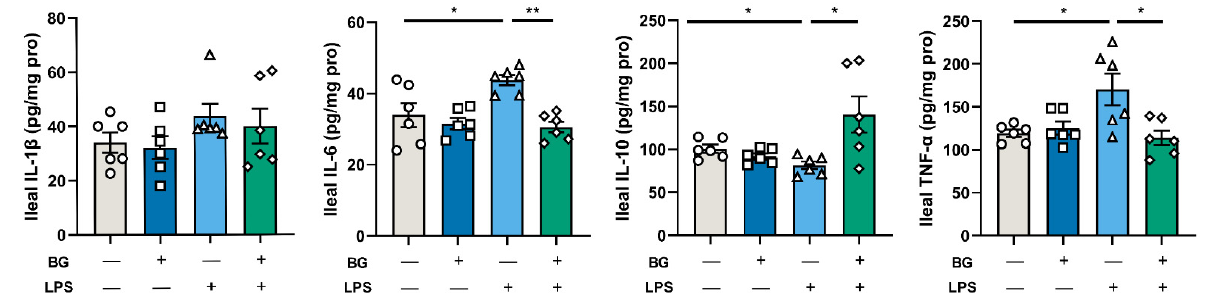
Figure 7. BG alleviated LPS-induced ileal intestinal inflammation response. Data are presented as mean ± SEM, n = 6. “+” and “ − ” mean with and without corresponding treatments, respectively. * and ** indicate significant difference ( p < 0.05 and p < 0.01, respectively). An unpaired t- test was used for statistical analysis between two groups.